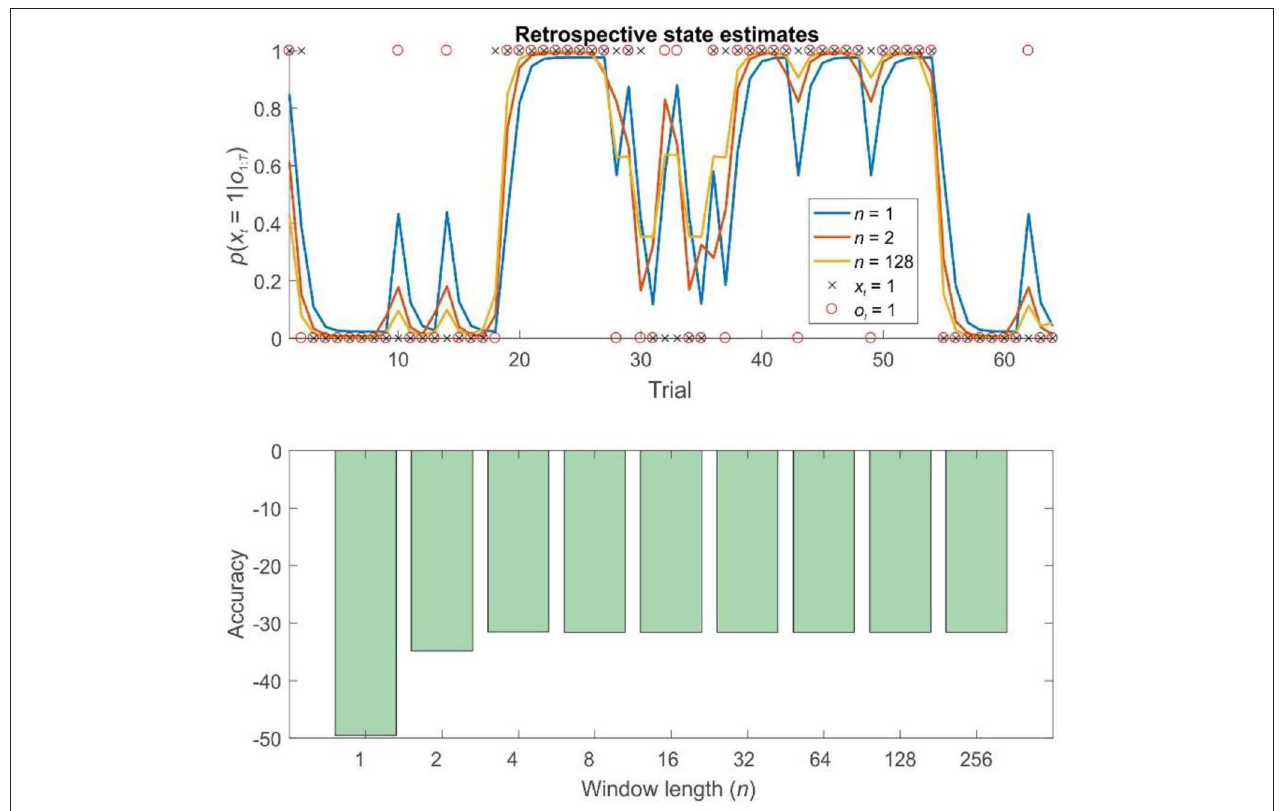
FIGURE 3 | Retrospective belief updating improves state estimates during pure inference on a probabilistic reversal task. Top panel: illustration of the first 64 trials of a 256 trial session of the reversal task using different strategies. The final (retrospective) posteriors are shown in blue ( n = 1, filtering), orange ( n = 2), and gold ( n = 128). Black crosses show the true hidden state, and red circles the observations made on each trial. Retrospective belief updating allows agents to infer the true underlying states more accurately. Bottom panel: relative log accuracy of models of different window lengths, averaged across simulated time series (see main text for details) (Accuracy is quantified as the log likelihood assigned to the true sequence of states by the agent, averaged across simulations). This illustrates that, in this context at least, even the use of a very short window leads to significantly more accurate beliefs, but that this benefit saturates relatively rapidly (by about n = 8). Thus, for a bounded rational agent performing pure inference, the optimal window length may be surprisingly low, depending on the relevant computational